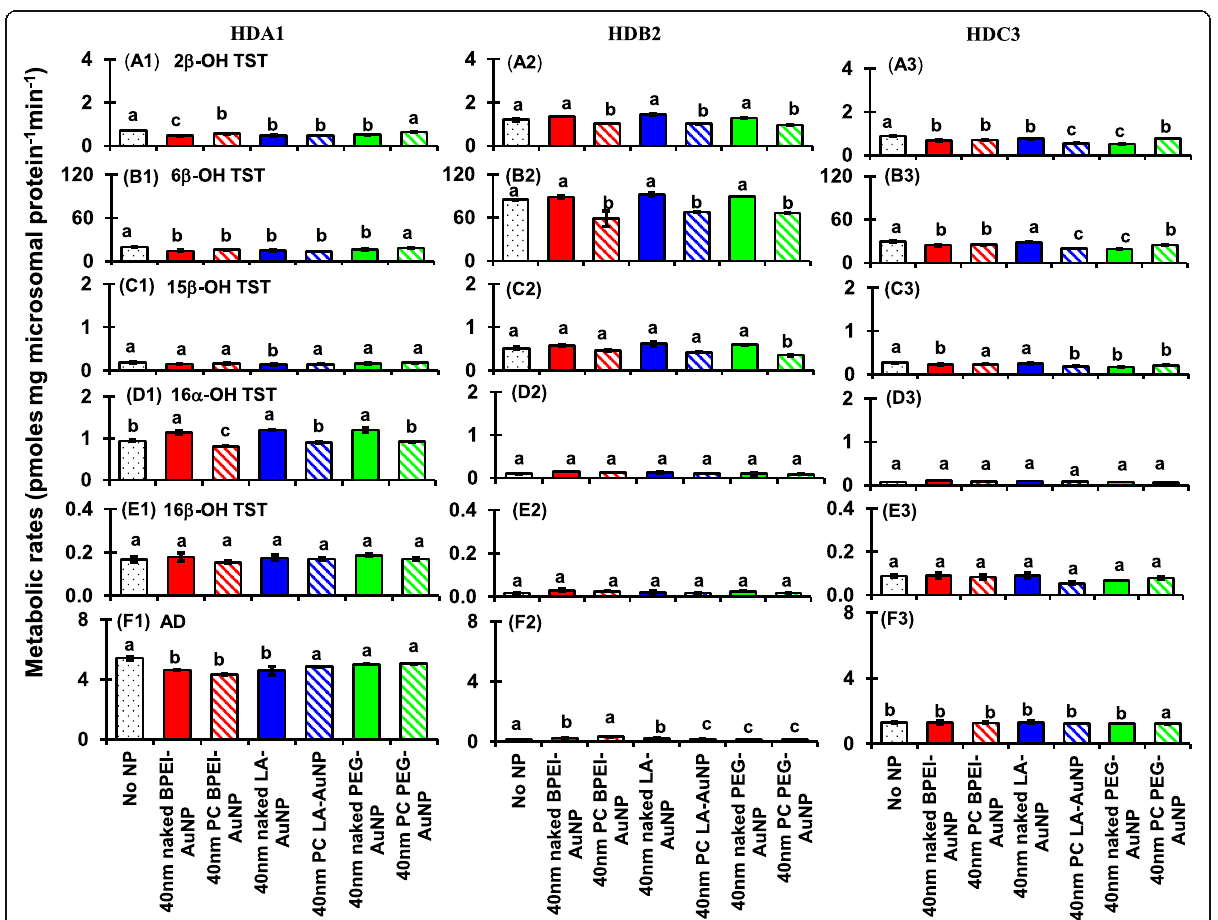
Fig. 8 Effects of 40 nm naked and PC AuNP on the production of 2 β -OH TST (A1 – A3), 6 β -OH TST (B1 – B3), 15 β -OH TST (C1 – C3), 16 α -OH TST (D1 – D3), 16 β -OH TST (E1 – E3), and AD (F1 – F3); in three different single donor HLM (HDA1, HDB2, and HDC3). Means followed by the same letter were not significantly different for each nanoparticle (Tukey ’ s honest significant difference = 5%). Naked no PC, PC human plasma protein corona, HLM human liver microsomes, BPEI branched polyethylenimine, LA lipoic acid, PEG polyethylene glycol, 2 β - OH TST 2 β -hydroxytestosterone, 6 β - OH